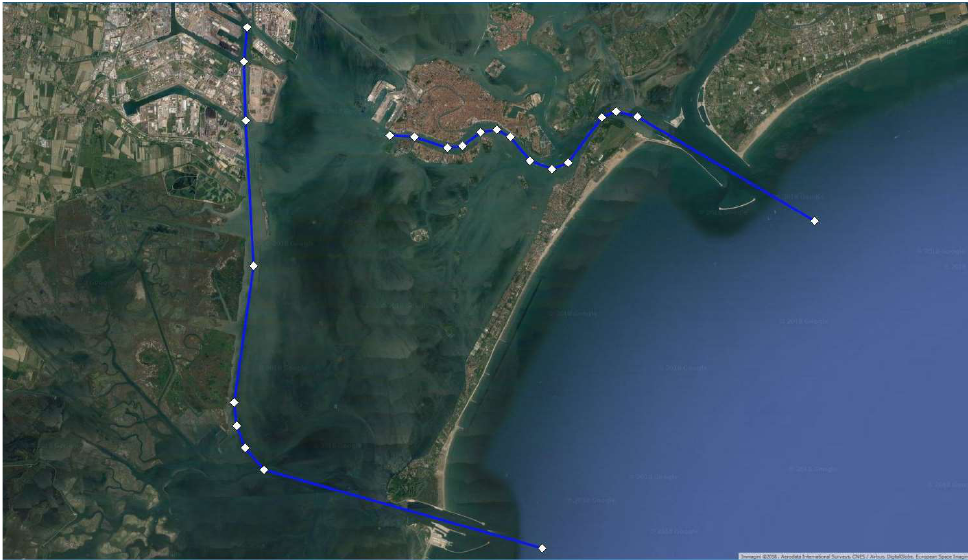
Figure 13. Virtual AtoN for the areas of Lido and Malamocco.